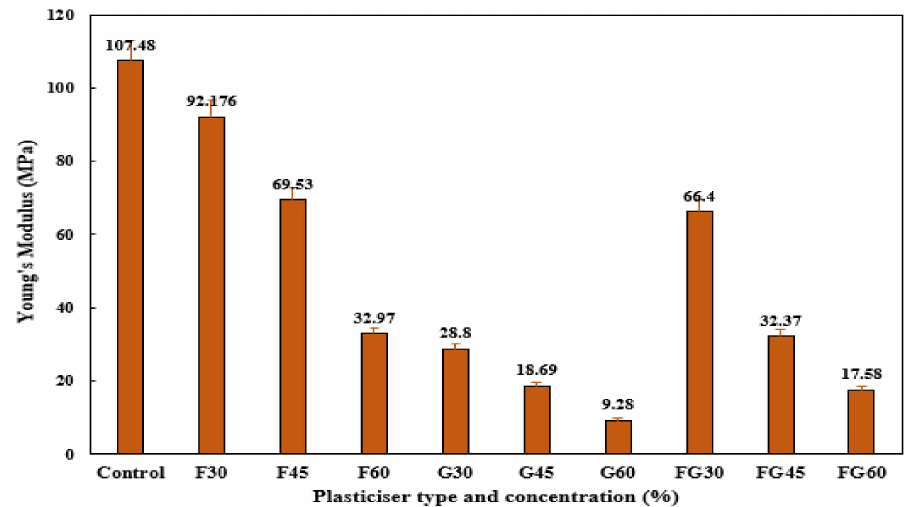
Figure 8. Young’s modulus of corn starch film with various plasticizer types at different concentra-